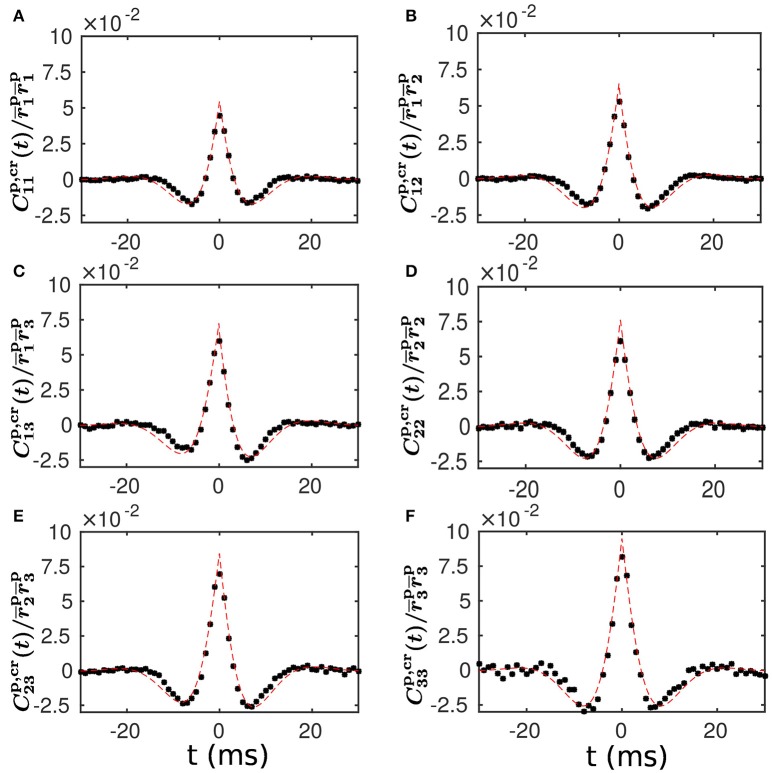
Population-averaged cross correlation—comparison between theoretical prediction and numerical results. (A–F) Normalized population-averaged cross correlation between the different populations. Note that Cαβp,cr for α, β = 1, 2, 3 is defined in Equation (20) and rαp for α = 1, 2, 3 is computed with Equations (12, 13) in a self-consistent way. The black dots are the cross correlation measured from a simulation of the LIF neuronal network with a static weight matrix. The red dashed line is the theoretical prediction of our linear response theory.